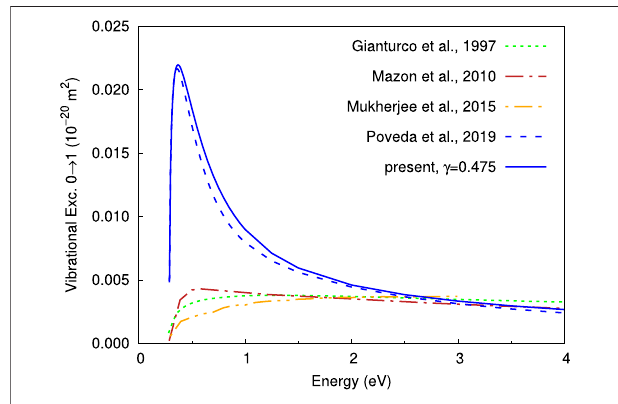
FIGURE 9 | (Color online) Comparison of the 0 → 1 vibrational excitation cross sections for N 2 . The present result correspond to a model potential with κ =0.5, ρ =2.05 and γ